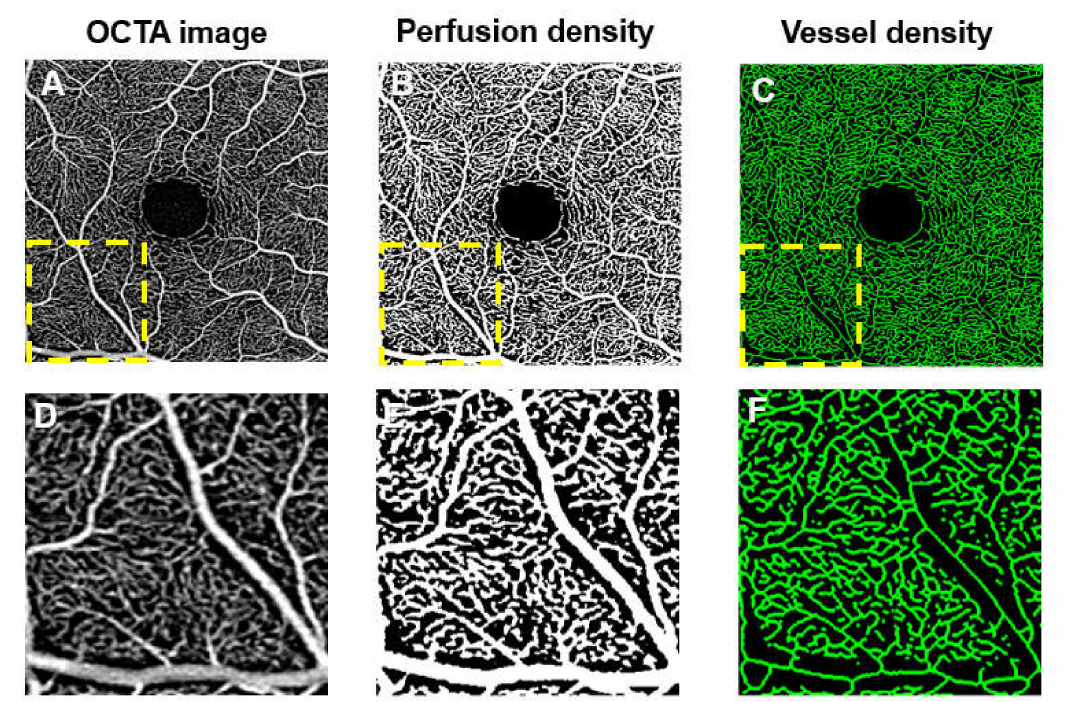
Figure 6. Optical coherence tomography angiography (OCTA) of the superficial capillary plexus ( A , D ) and post-processed images ( B , C , E , F ). Corresponding enlarged views of the images are shown in ( D – F ). ( A ) OCTA image is first extracted from the machine. ( B , E ) The image is then binarized to obtain the perfusion density. ( C , F ) To obtain the vessel density, the binarized image is further skeletonized. In perfusion density, large vessels count more towards the perfusion density measurements, while in vessel density, large vessels and small capillaries carry the same